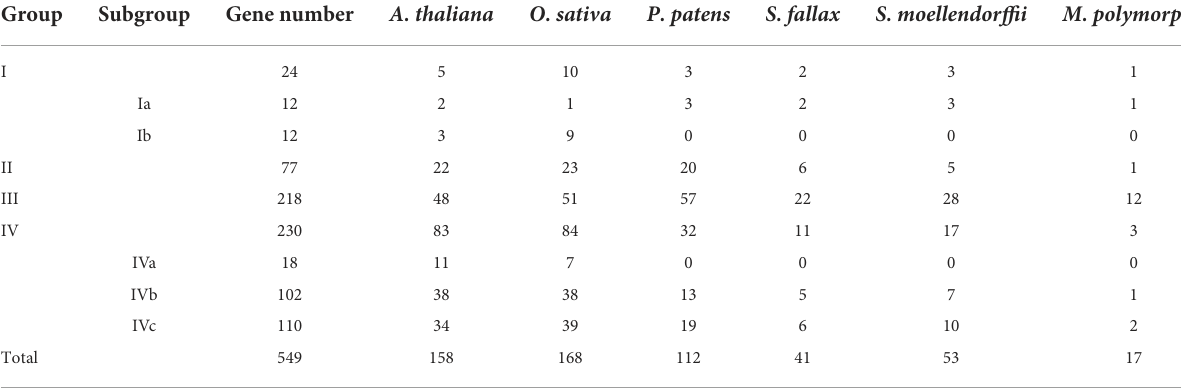
TABLE 2 Segmental duplication gene pairs in P. patens and A. thaliana . Group Subgroup